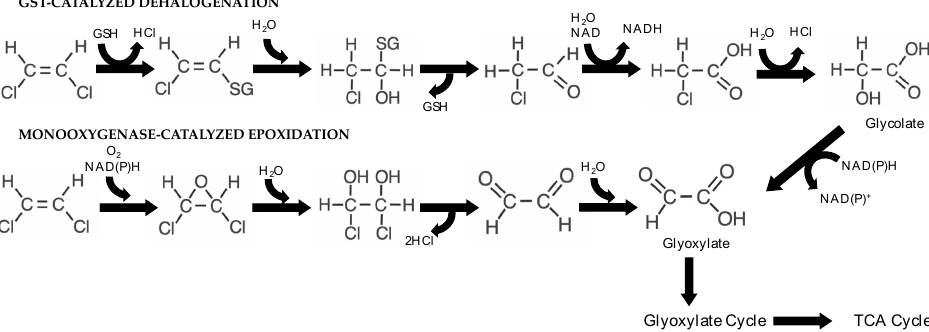
Figure 3. cis -DCE oxidation pathways (adapted from [61]). In the glutathione S-transferase (GST)- catalyzed dehalogenation, one chloride is replaced by glutathione